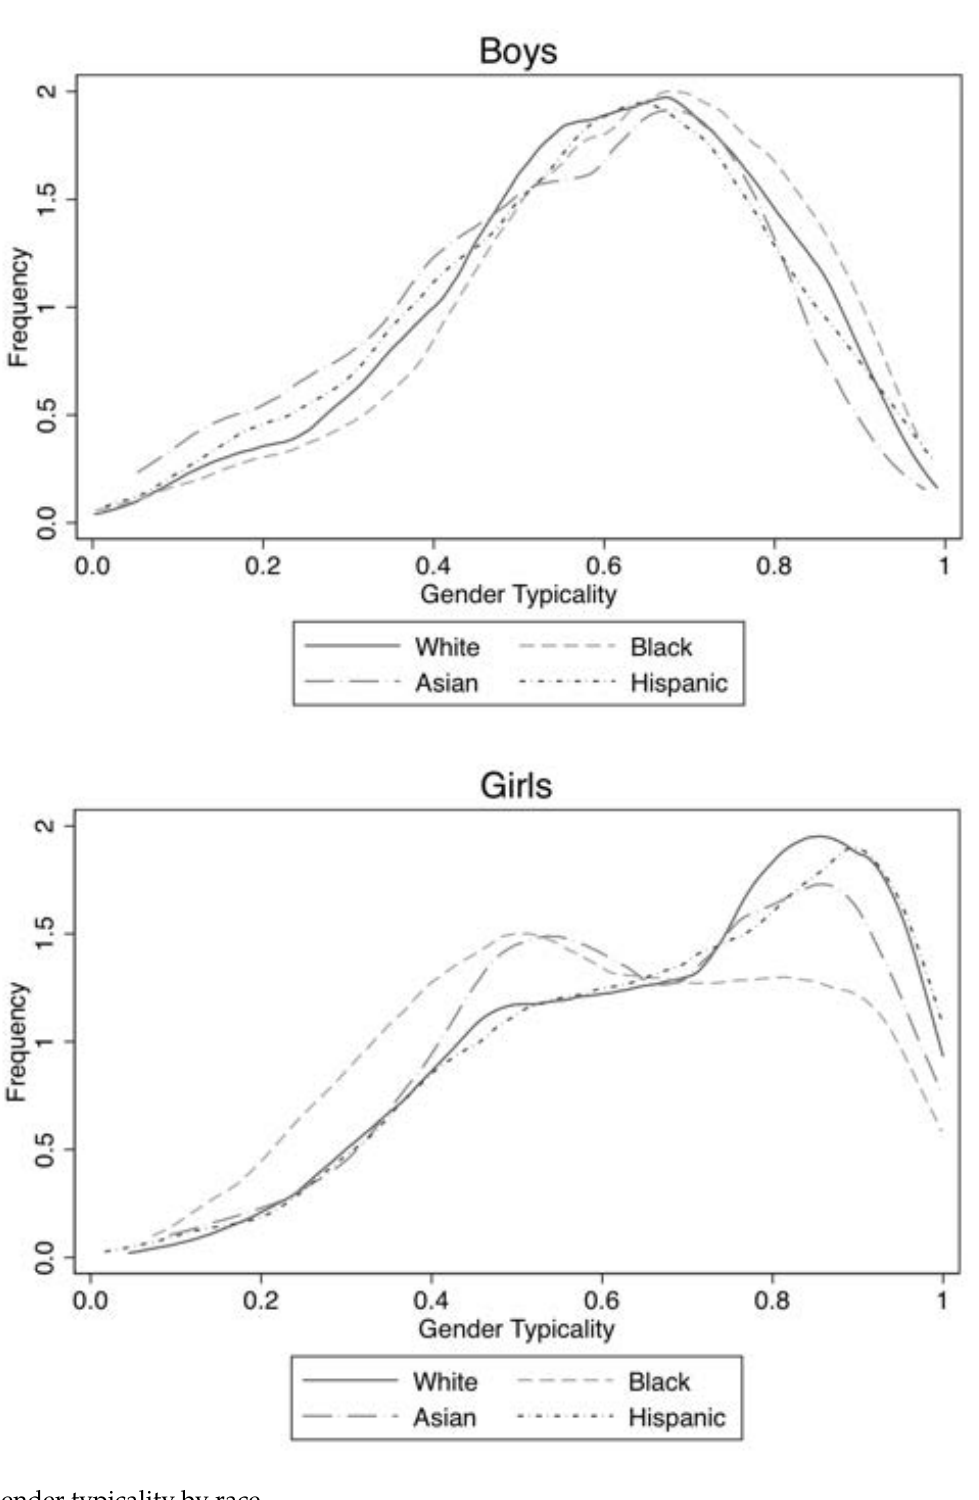
Figure 2: Gender typicality by